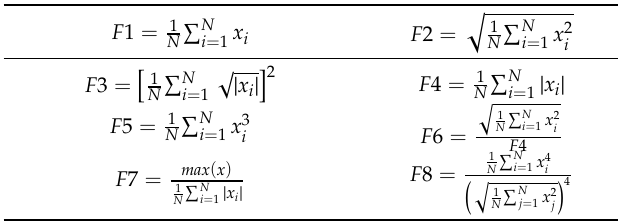
Table 3. Frequency-domain features.